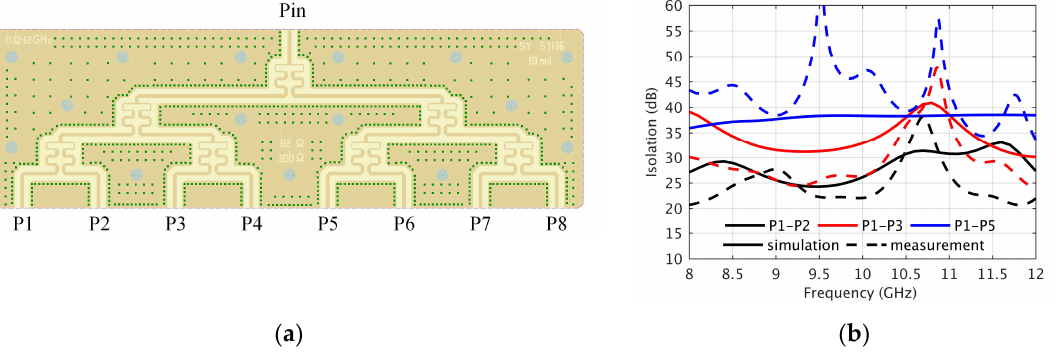
Figure 17. ( a ) LO power divider layout. ( b ) Simulation and measurement results of LO power di- vider